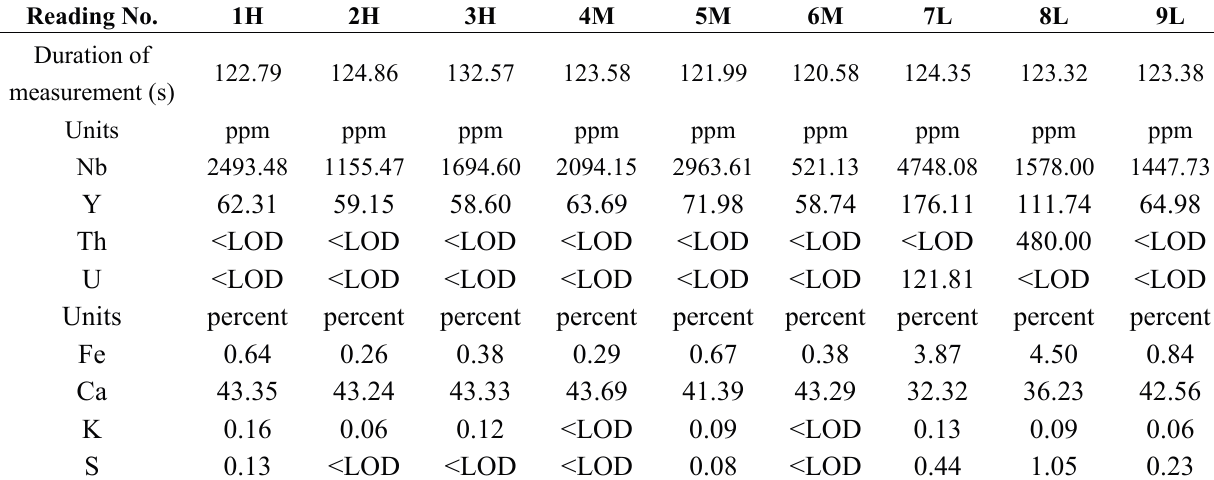
Table 3. Elemental compositions of nine ground field samples analyzed using the handheld XRF. All samples had calcium concentrations of between ca . 35% and 45%. The lower calcium concentrations were observed in samples 7L and 8L. These two samples also had higher concentrations of iron, yttrium, thorium and uranium. However, all samples can be subdivided into pure calcium carbonatites (1H, 2H, 3H, 4M, 5M, 6M and 9L) and the two siderite bearing carbonatite samples enriched with Th, U, Y and REEs (7L and 8L). LOD represents the limit of